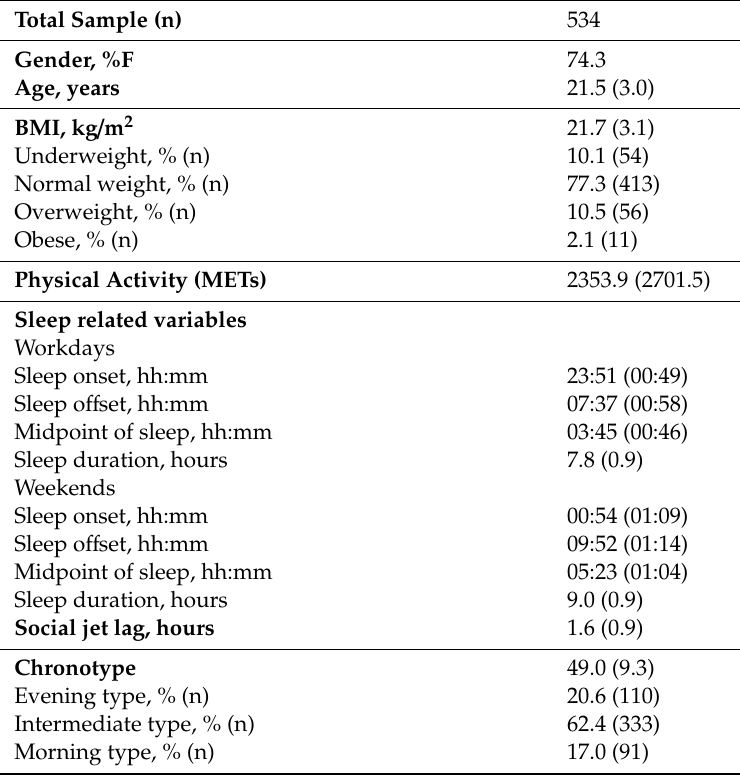
Table 1. General characteristics of the population studied.